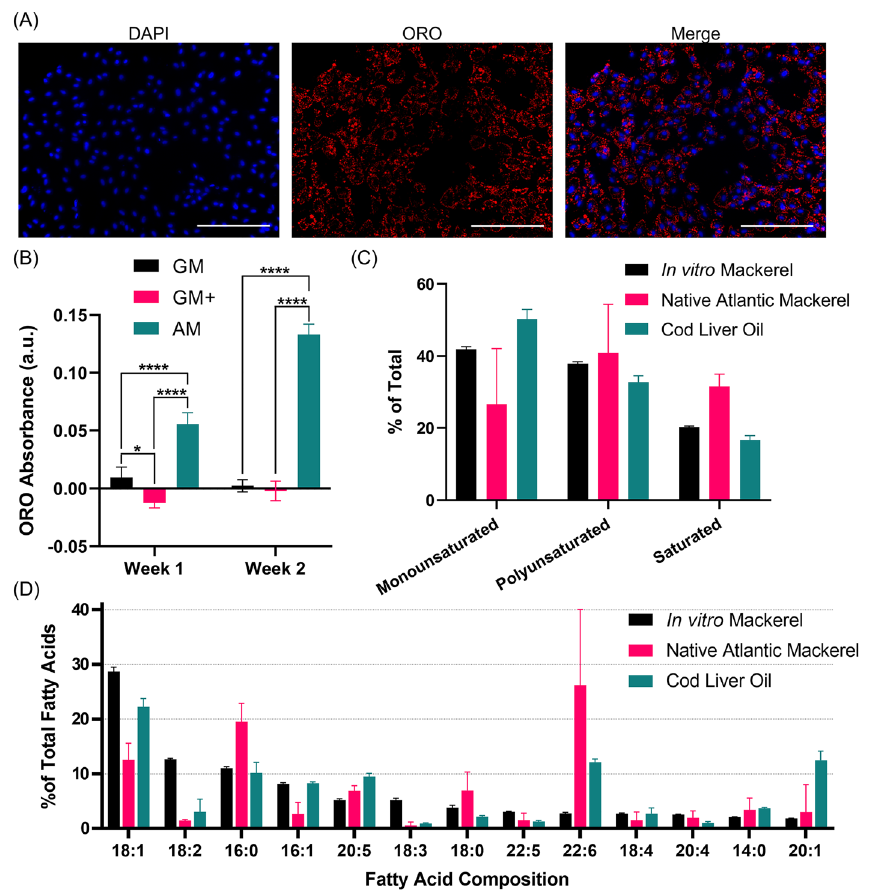
Figure 4. Lipid accumulation in Mack muscle cells. ( A ) Immunofluorescence staining for cell nuclei (DAPI, blue) and neutral lipids (Oil Red O, red). ( B ) Quantification of neutral lipid accumulation in different media through Oil Red O absorbance. GM: growth medium, GM+: growth medium + PPARG agonists, AM: adipogenic medium (GM+ with lipid mixture). ( C ) Percent of fatty acid saturation in adipogenic-like mackerel muscle cells, native Atlantic mackerel (adapted from 23–26 ), and cod liver oil (adapted from 27,28 ). Error bars indicate standard deviation, n = 3. (D) Fatty acid composition of adipogenic-like mackerel cells, native Atlantic mackerel (adapted from 22,23,25,26 ), and cod liver oil (adapted from 27–29 ). The top 13 most prevalent fatty acids from the in vitro mackerel are shown. Error bars indicate standard deviation, n =